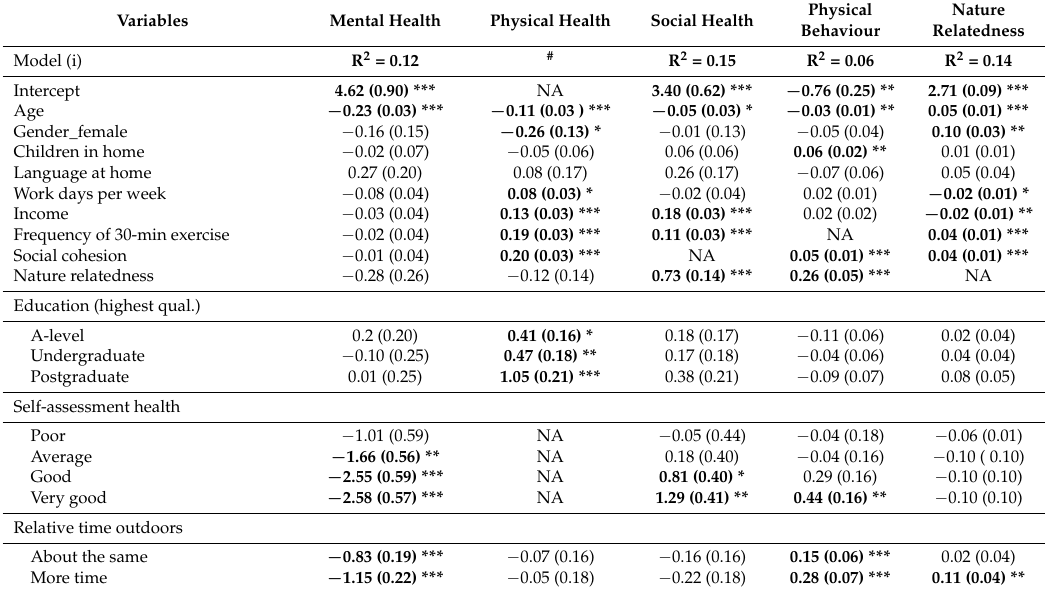
Table 1. The relationship between five health responses and (i) socio-demographic only; (ii) plus frequency; (iii) plus duration and (iv) plus